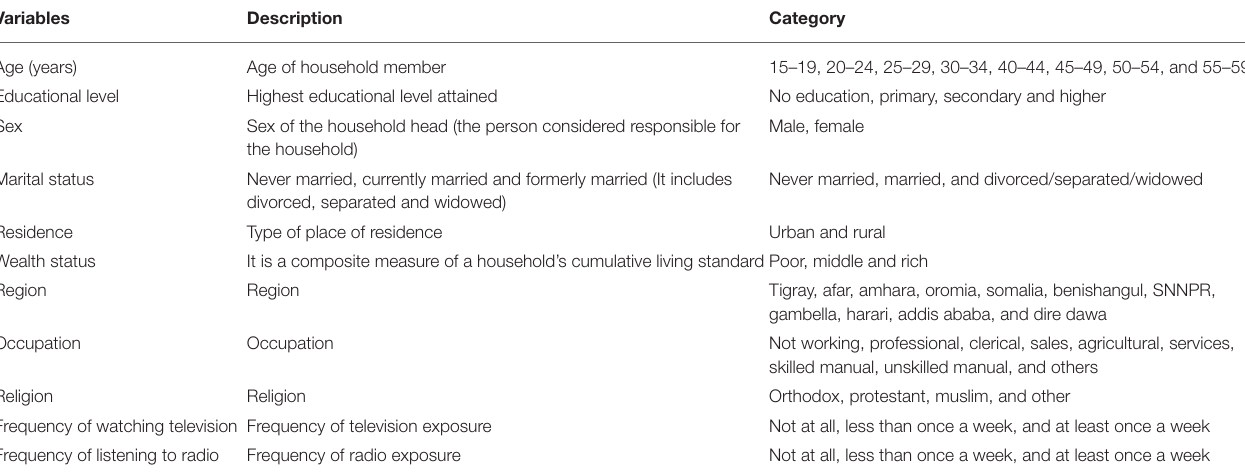
TABLE 1 | Description of explanatory variables used in the